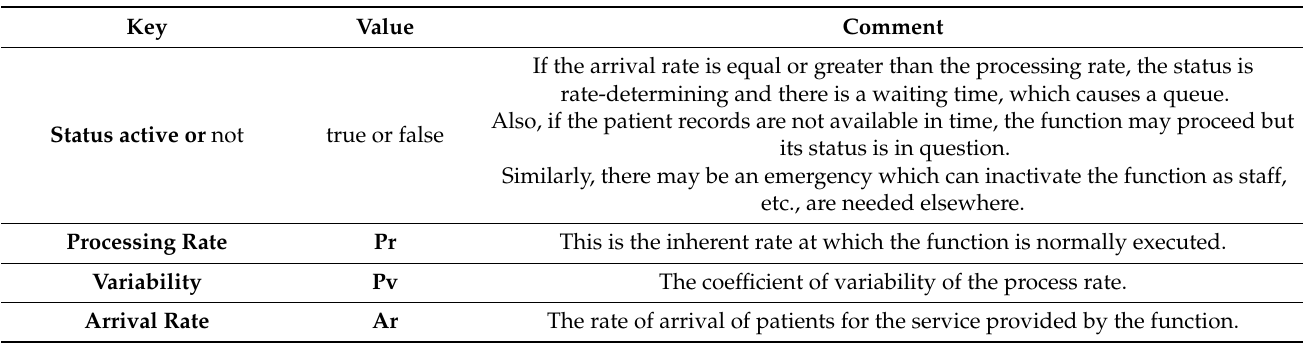
Table 1. Possible metadata pairs for the scenario above.